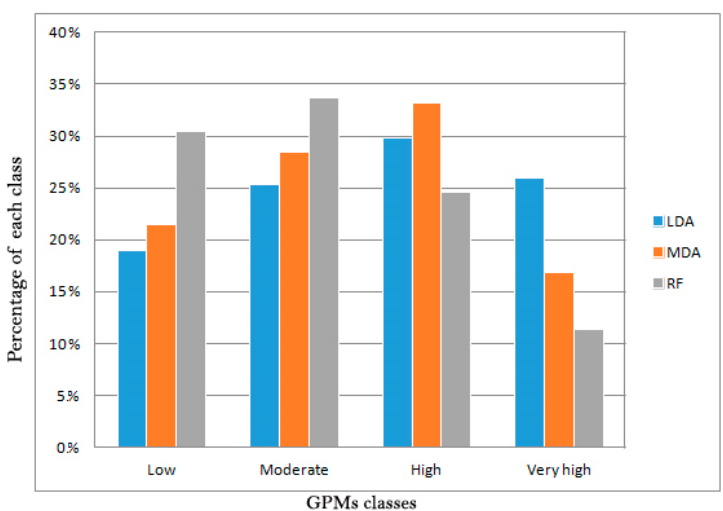
Figure 6. The percentage of four predicted classes in GPMs derived from LDA, MDA and RF modeling.